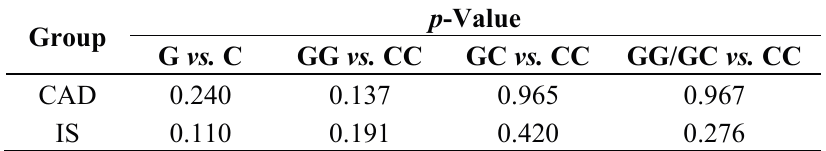
Table 4. Egger’s linear regression test for funnel plot